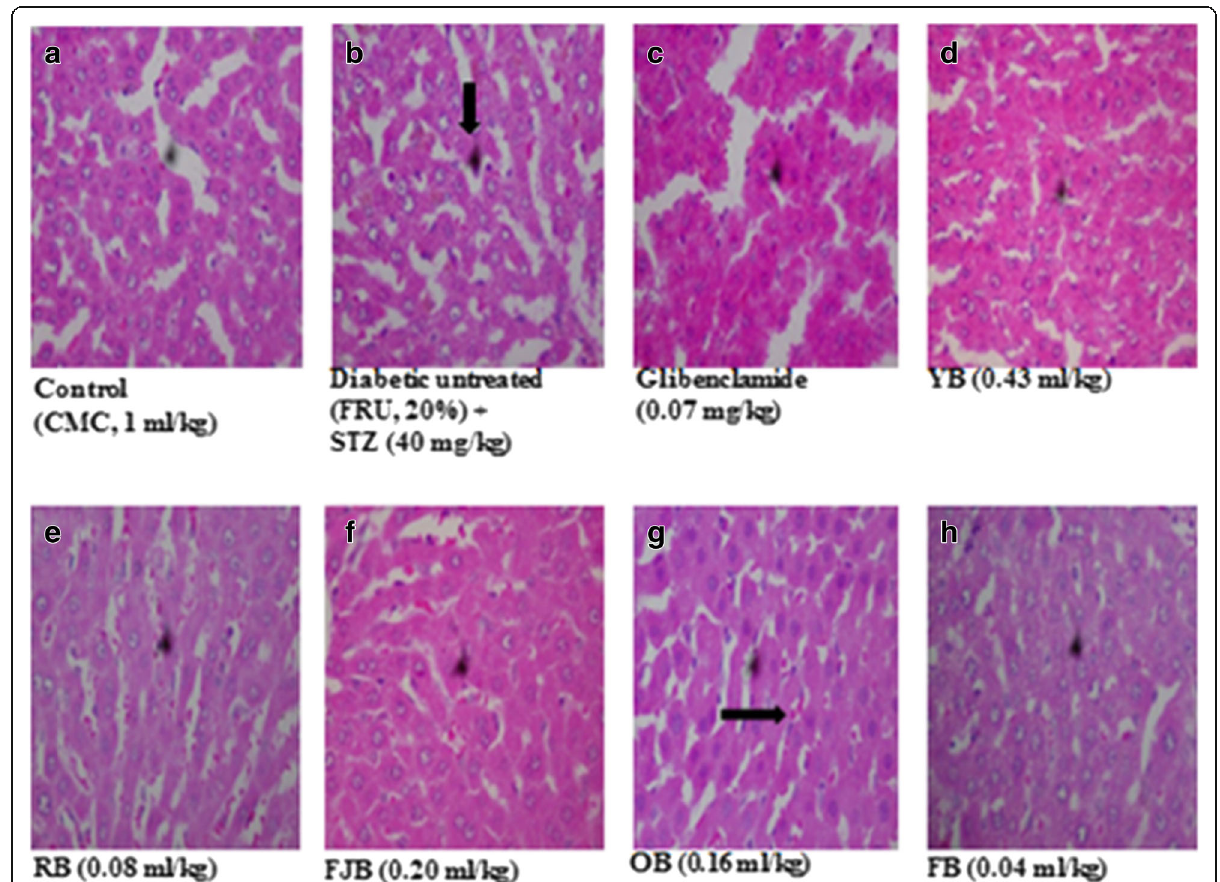
Fig. 7 sections of LIVER show ( a ) hepatocytes arranged as radial plates. No fatty change, vascular congestion or infiltration of parenchyma by inflammatory cells is seen. ( b ) radial plates of hepatocytes. The hepatic sinusoidal congestion are packed with red cells ( c ) radial plates of hepatocytes. The hepatic sinusoidal congestion are packed with red cells. d hepatocytes arranged as radial plates. No fatty change, vascular congestion or infiltration of parenchyma by inflammatory cells seen. ( e ) hepatocytes arranged as radial plates. No fatty change, vascular congestion or infiltration of parenchyma by inflammatory cells seen. f hepatocytes arranged as radial plates. No fatty change, vascular congestion or infiltration of parenchyma by inflammatory cells is seen. g radial plates of hepatocytes. The hepatic sinusoidal congestion are packed with red cells. h hepatocytes arranged as radial plates. No fatty change, vascular congestion or infiltration of parenchyma by inflammatory cells seen. FRU: Fructose. STZ: Streptozotocin. CMC: Carboxy methyl cellulose . (H & E, mag. X